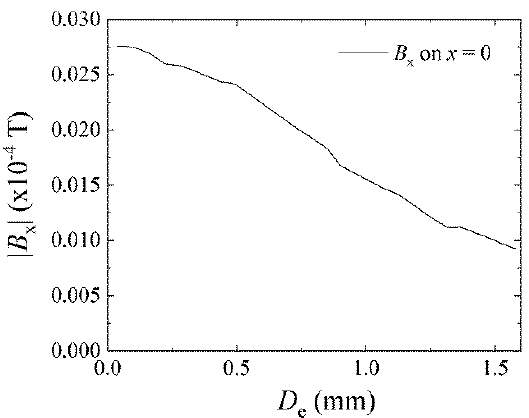
Figure 19. Variation of magnetic field B x as a function of the distance from the element D e .